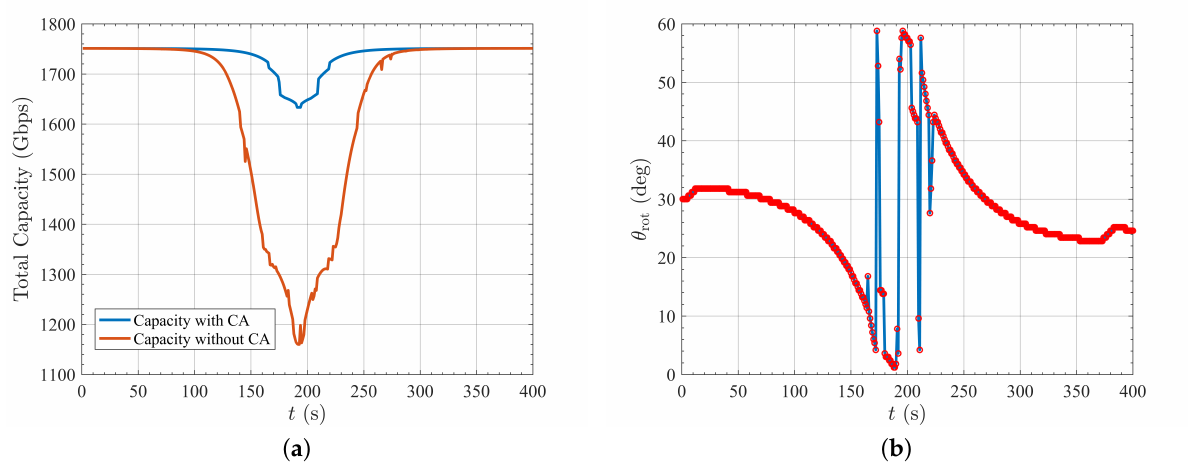
Figure 10. Change of total capacity with and without channel allocation and variation of rotation angle for the seven-beam scenario. ( a ) Change of total capacity with and without channel allocation for the seven-beam scenario; ( b ) Variation of rotation angle for the seven-beam